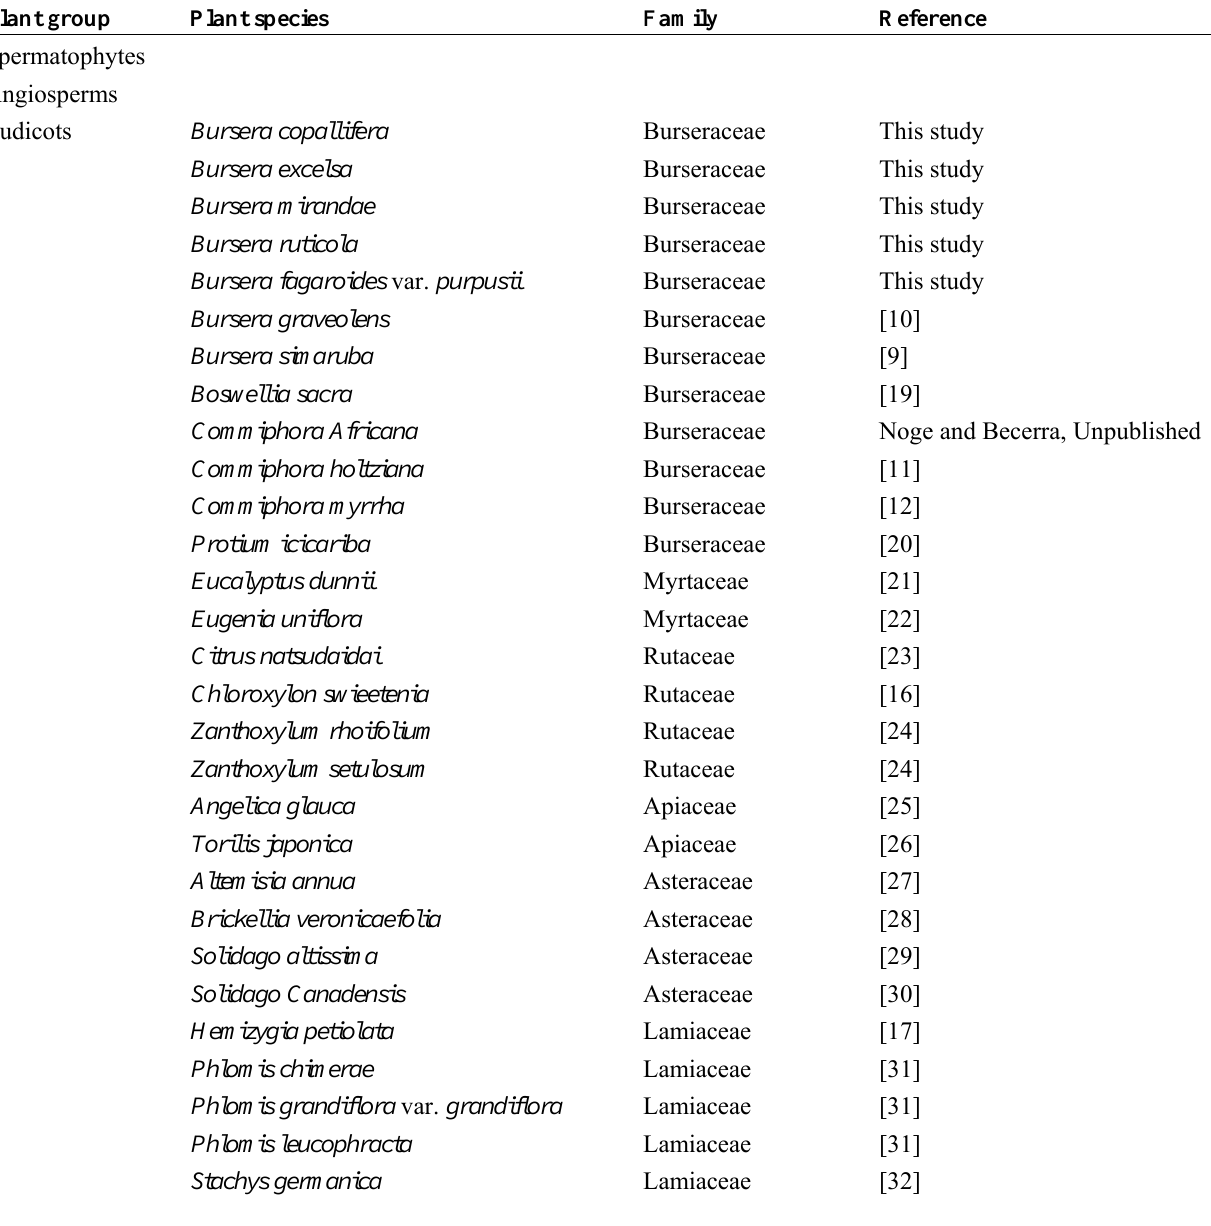
Table 2. Examples of the presence of germacrene D in